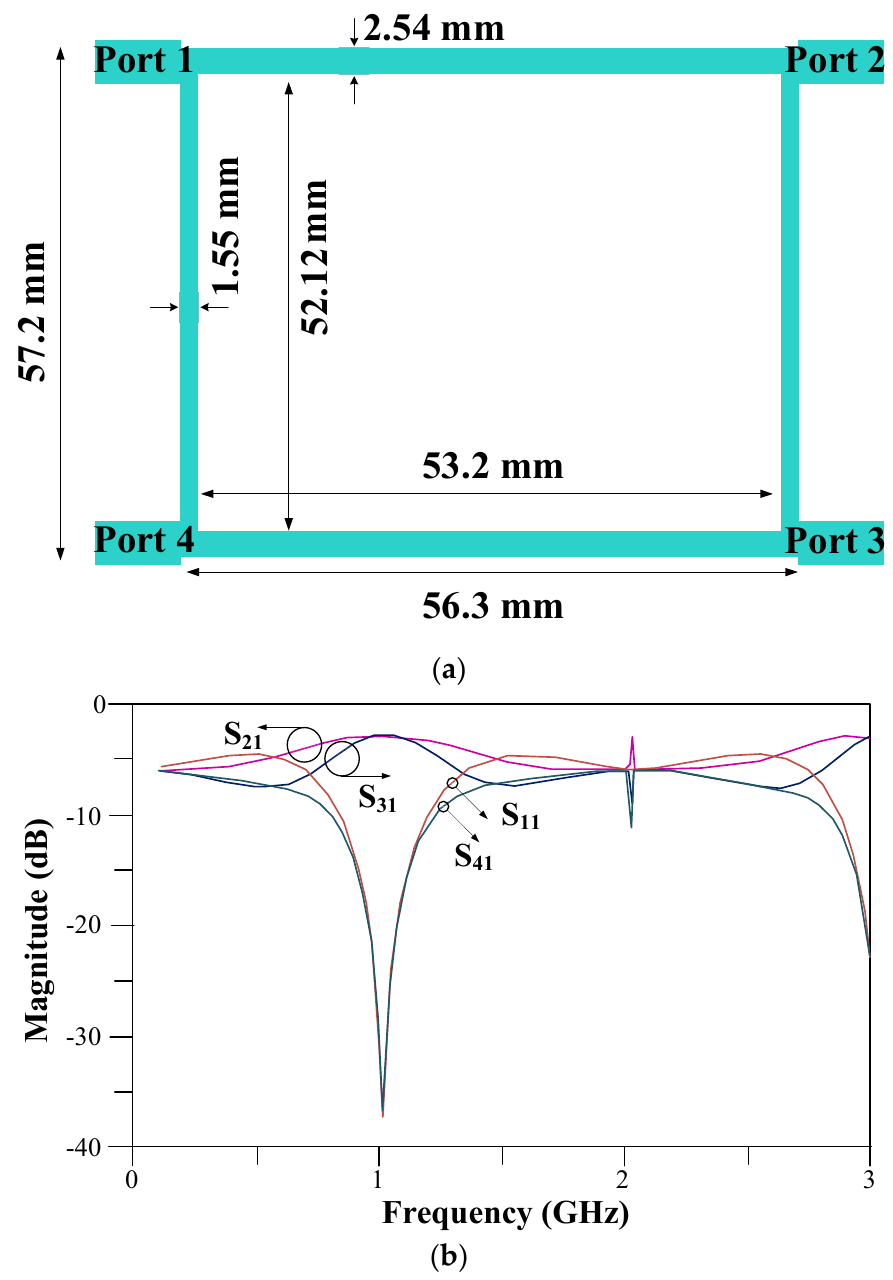
Figure 1. BLC operating at 1 GHz: ( a ) conventional structure and ( b ) frequency response. All dimensions are in the millimeter unit.